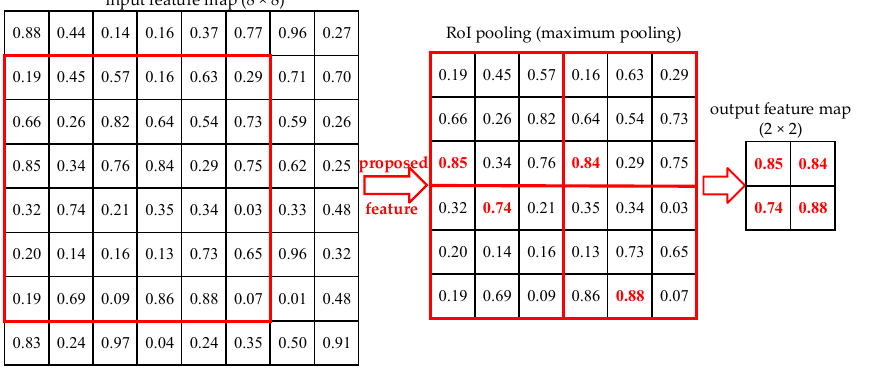
Figure 4. Operating principle of RoI pooling layer.